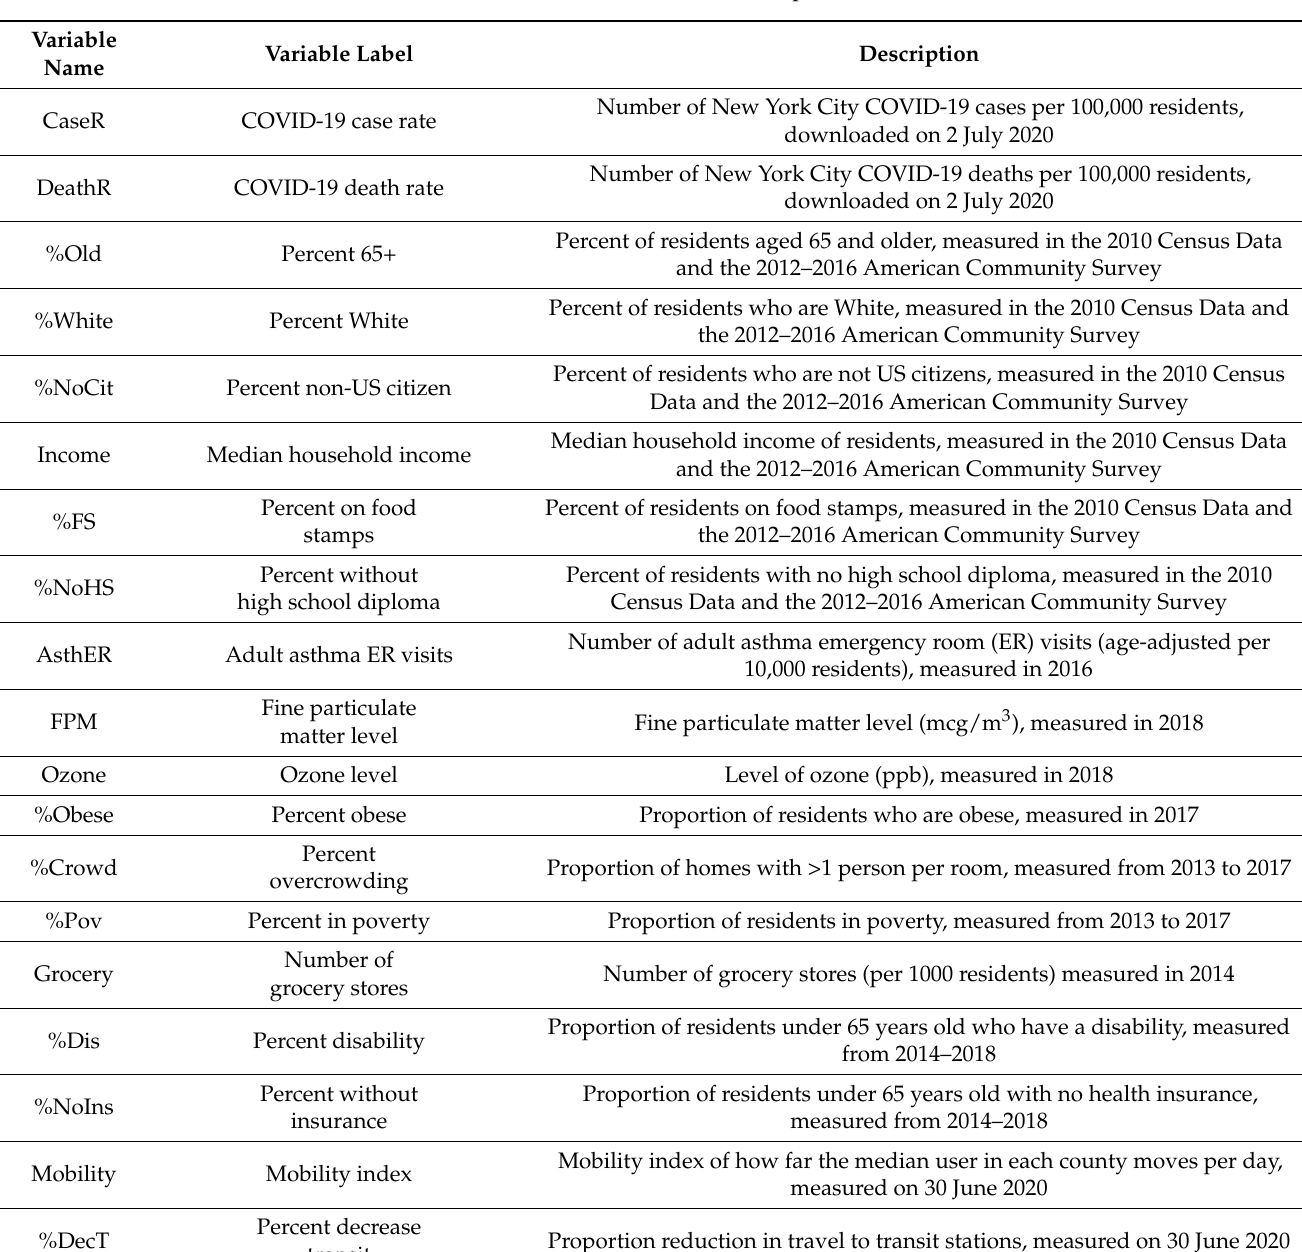
Table 2. Variable names and